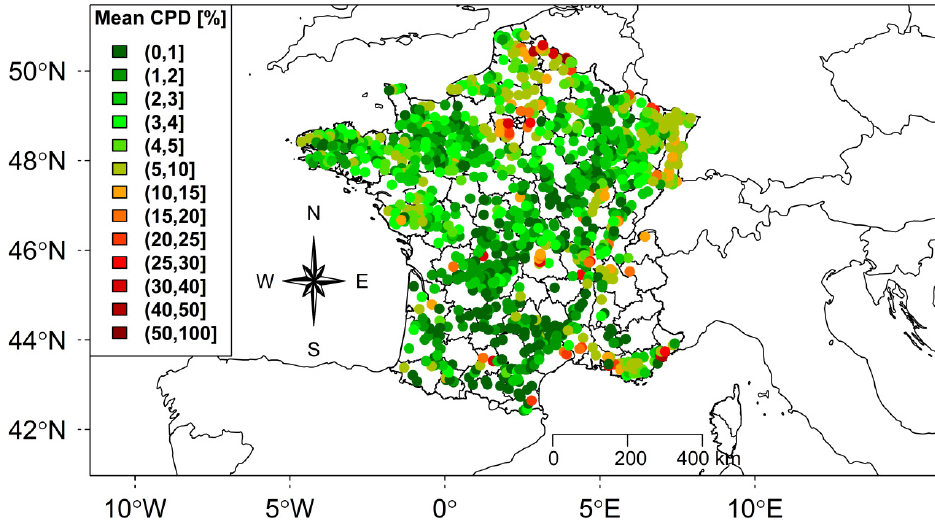
Figure 2. The location and mean CPD of the 1355 French